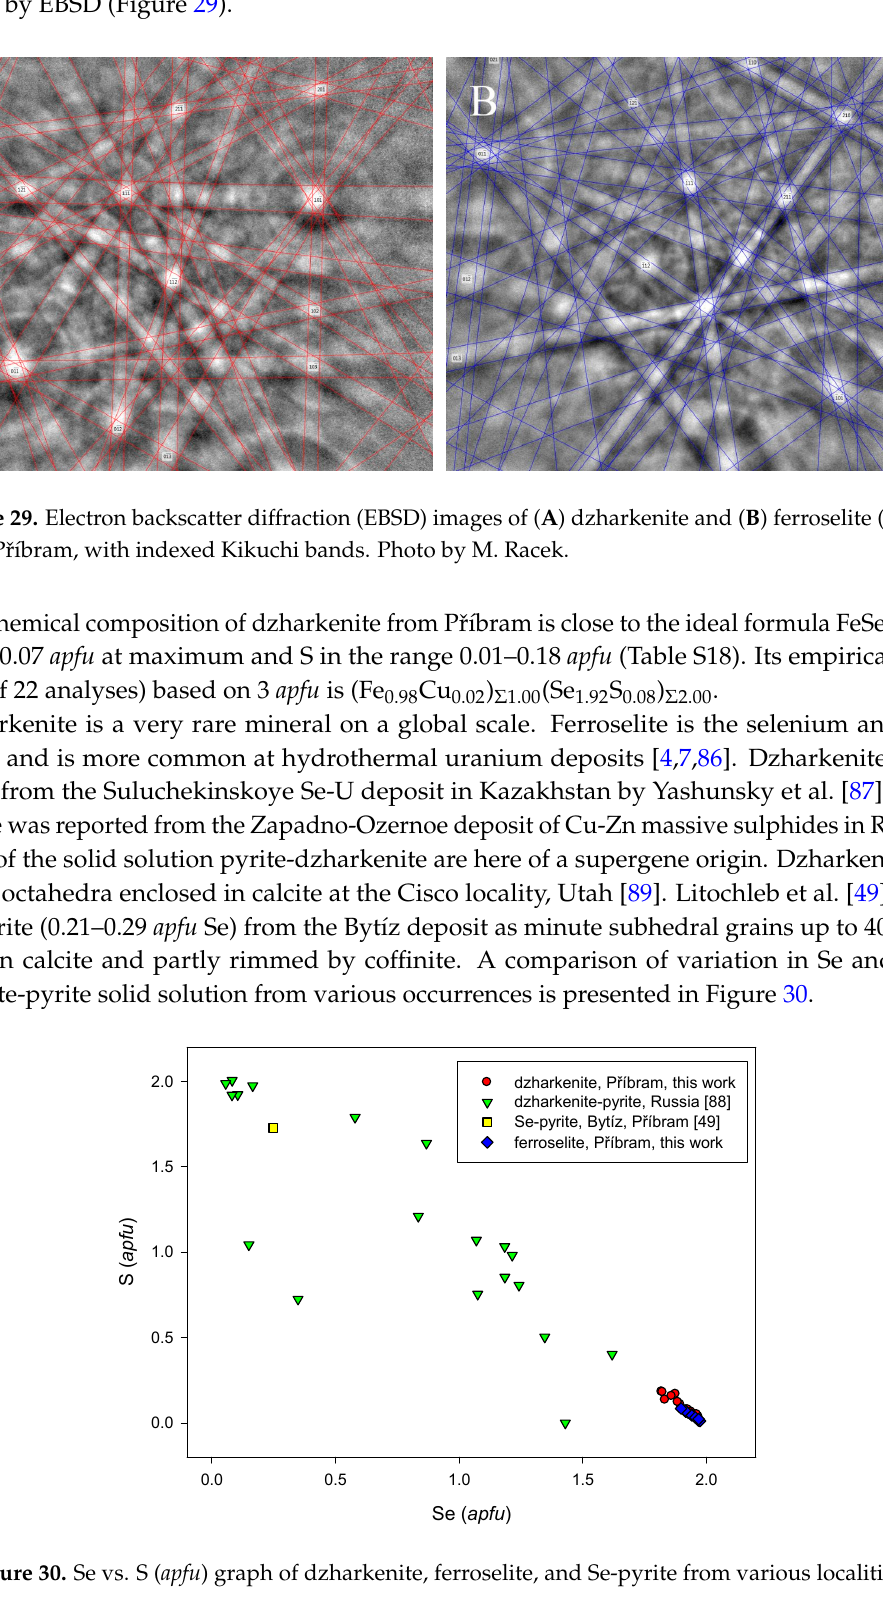
Figure 28. Pinkish subhedral dzharkenite grain in association with dark grey tetrahedrite enclosed light grey tiemannite inclusions. Reflected light, one polarizer. FOV 210 μ m. P ř íbram, a dump of shaft 16. Photo by P. Škácha.